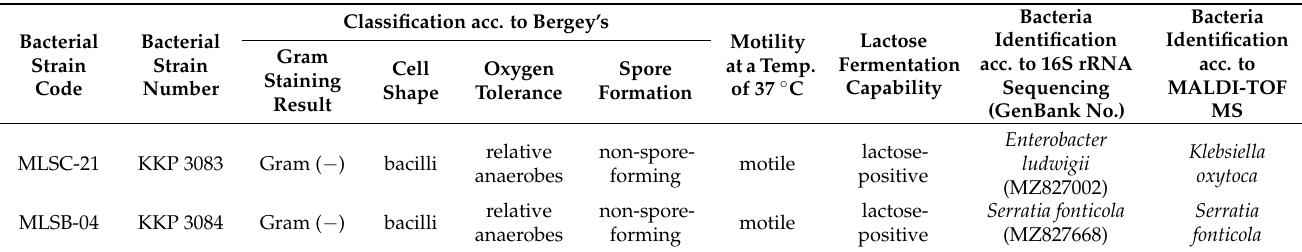
LB) agar overlays with 2